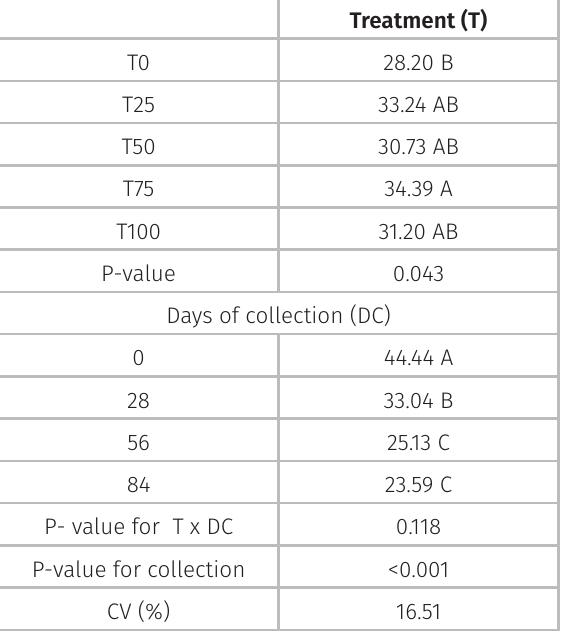
Table IV. Blood calcium levels (mg/dL) of the hens submitted to the treatments at the different collection periods, that is, at the beginning of the experiment (day 0) and at the end of each production cycle (days 28, 56 and